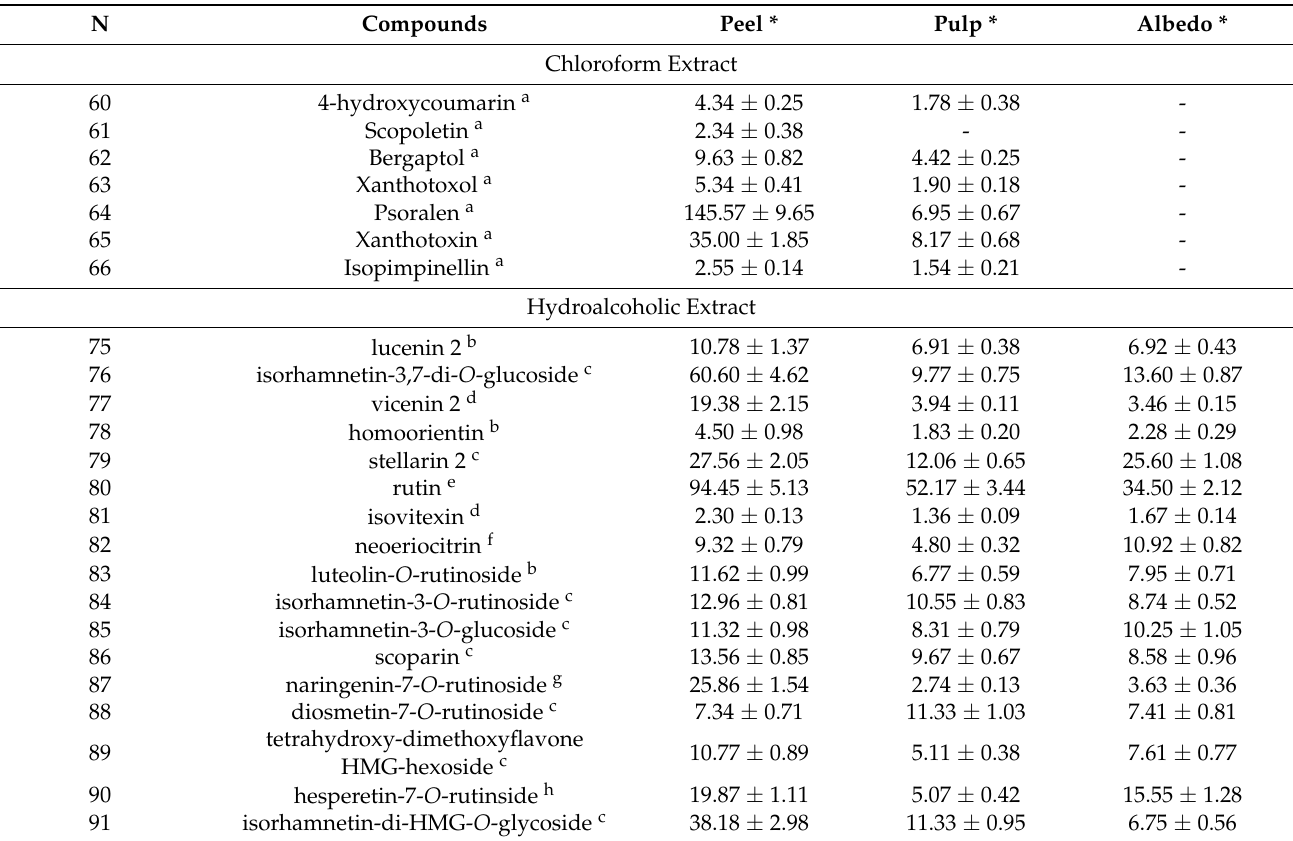
Table 4. Semi-quantitative analysis of non-volatile